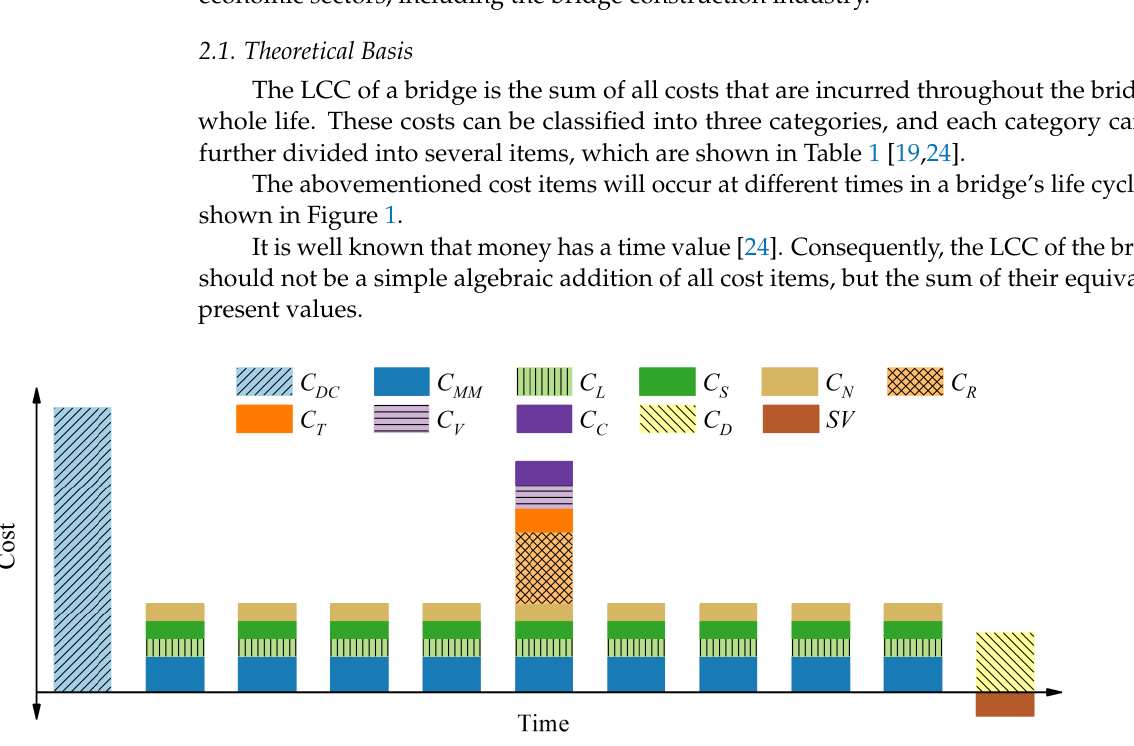
Figure 1. Timeline of various cost items in a bridge’s life cycle.